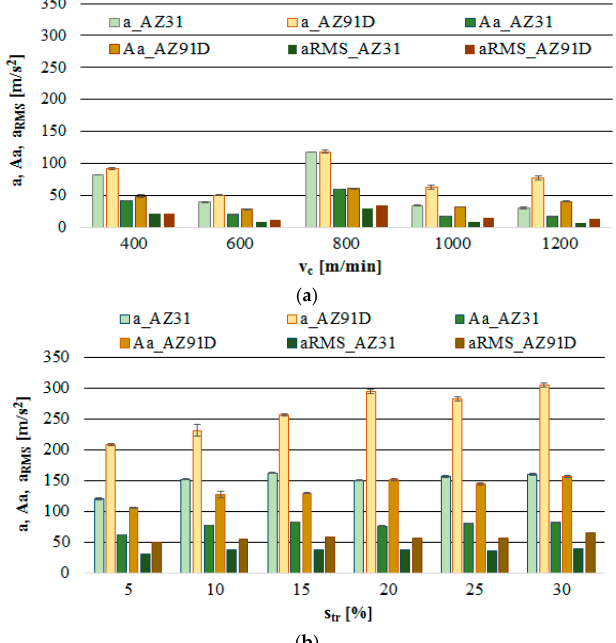
Figure 11. Maximum value of vibrations acceleration, amplitude and RMS in the milling of magnesium alloys: ( a ) effect of cutting speed v c (f z = 0.15 mm/tooth, a p = 6 mm and s tr = 15%) and ( b ) effect of trochoidal step s tr (v c = 800 m/min, f z = 0.15 mm/tooth and a p = 6 mm).